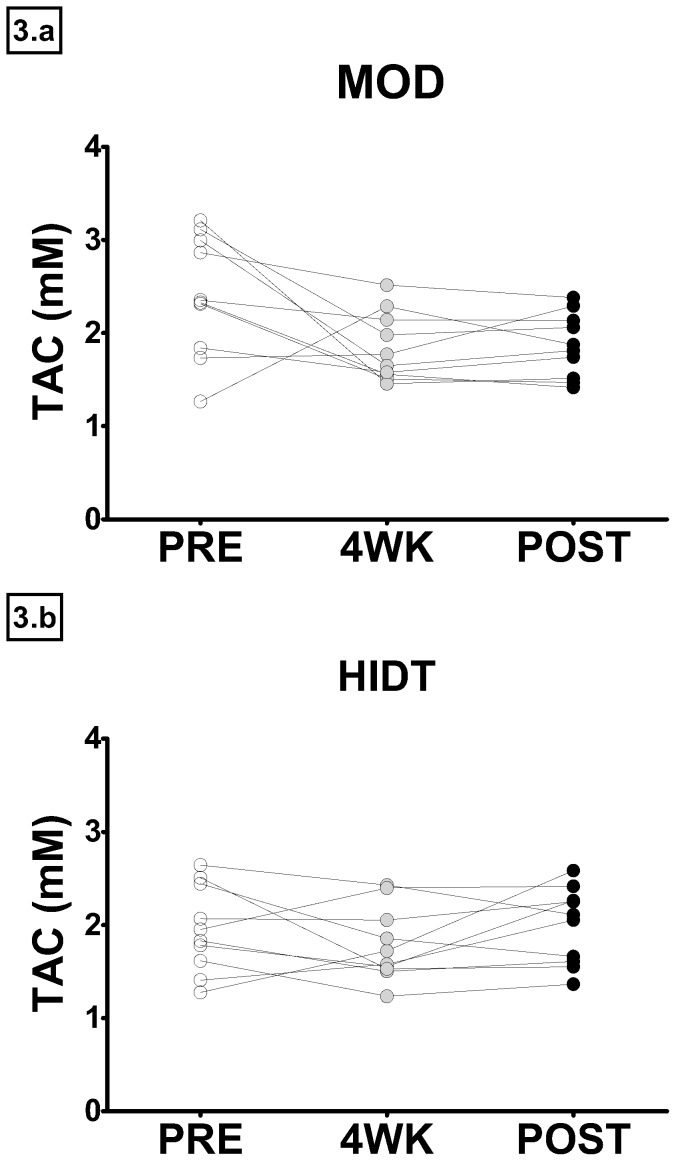
Individual changes in TAC value in MOD and HIDT.White squares represent pre-training (PRE) values and black squares represent post-training (POST) values.